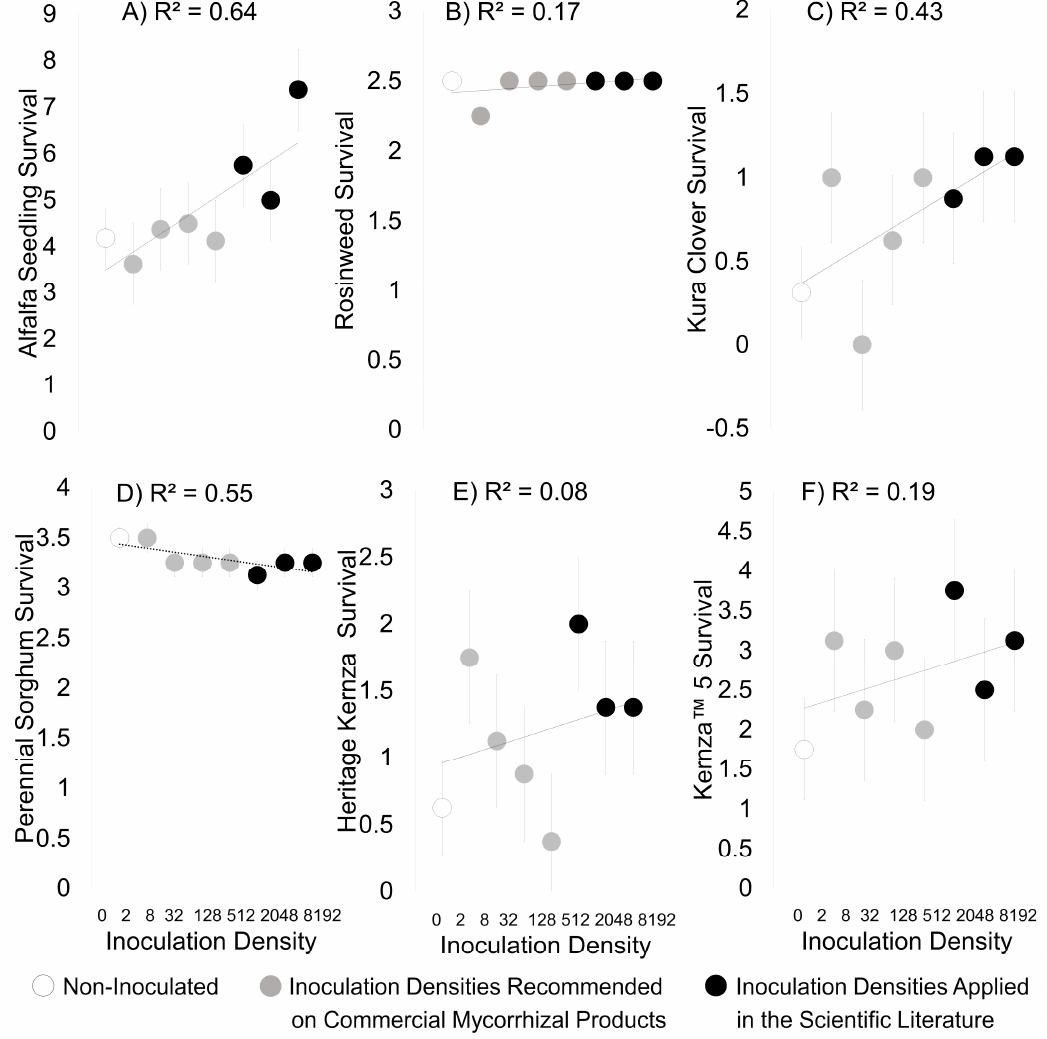
Figure 2. Plant survival and establishment in the field when plants were grown with no mycorrhizal inoculation (white, open circles ○ ), with densities of mycorrhizal amendment recommended by commercial producers if inoculum (grey circles ● ), and with mycorrhizal amendment densities that have been shown to be e ff ective in the scienti fi c literature (black circles ● ). The survival of some plants was positively ( A , C ) or negatively ( B , D ) e ff ected by mycorrhizal density, while others were una ff ected by mycorrhizal application ( E , F ). Dots represent the average plant number when plants were grown with each of the eight inoculation densities, error bars are standard error, and lines are best fit lines for plants that had a linear response relationship with inoculation